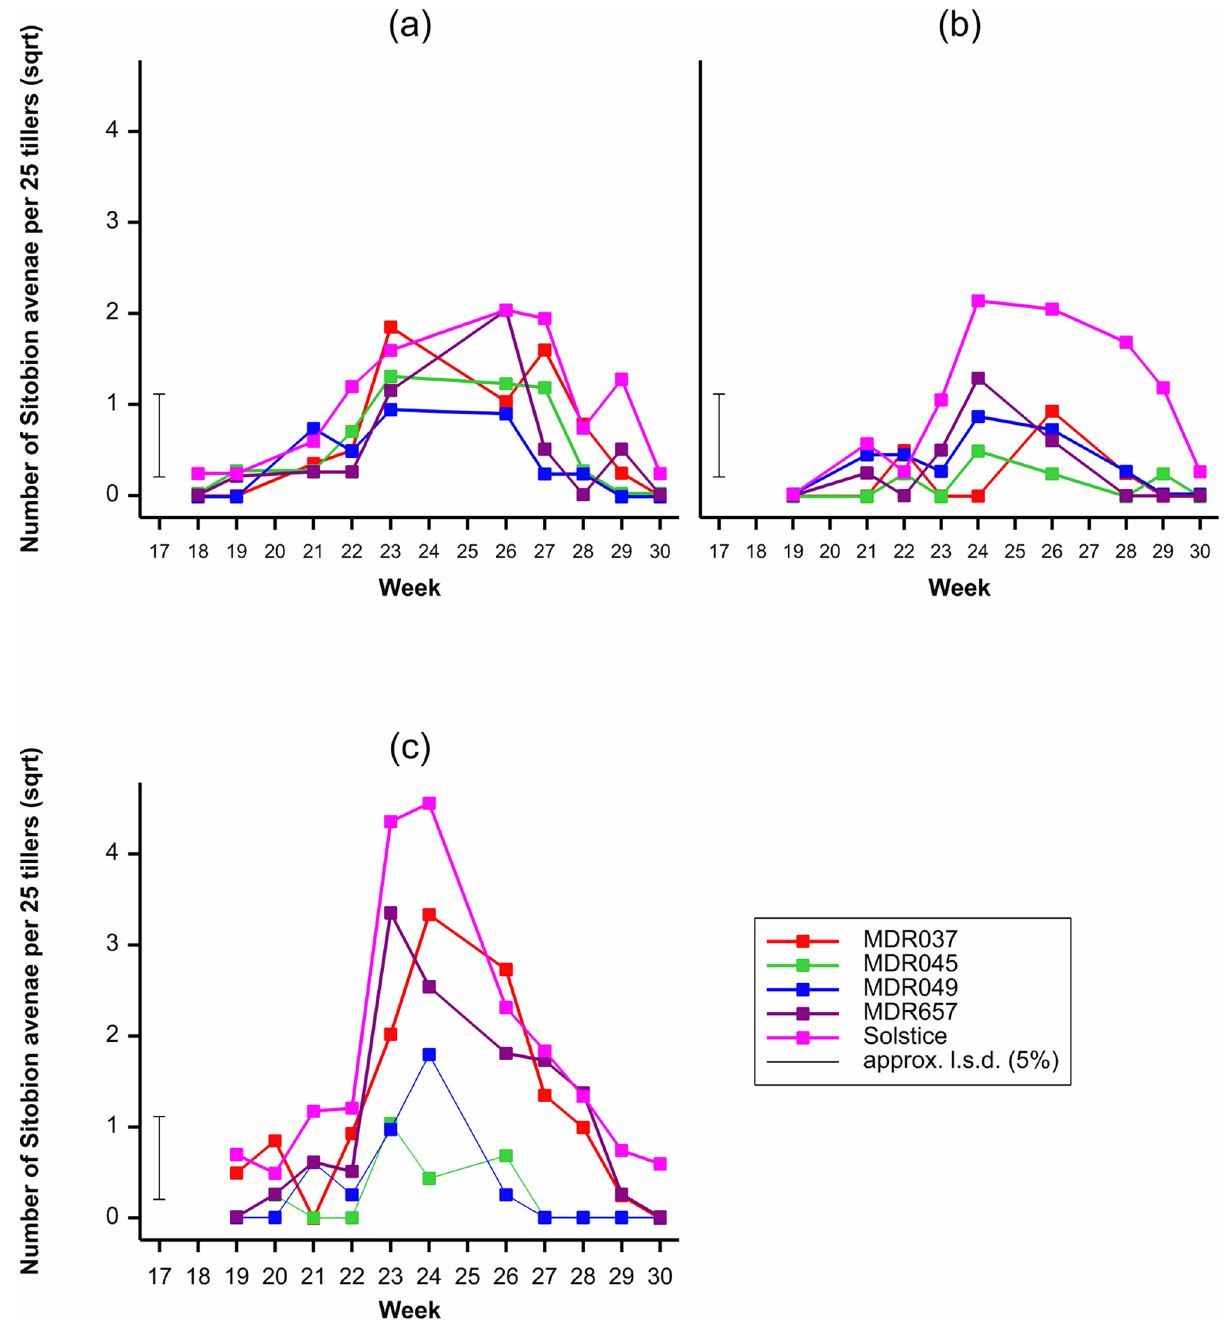
Figure 2. Average number of Sitobion avenae per 25 tillers observed on Triticum aestivum Solstice, Triticum moncoccum MDR037, MDR657, MDR045 and MDR049 in field trial ( a ) Year 1 (2017), ( b ) Year 2 (2018), ( c ) Year 3 (2019) from week 18 to week 30. All data was subject to square root